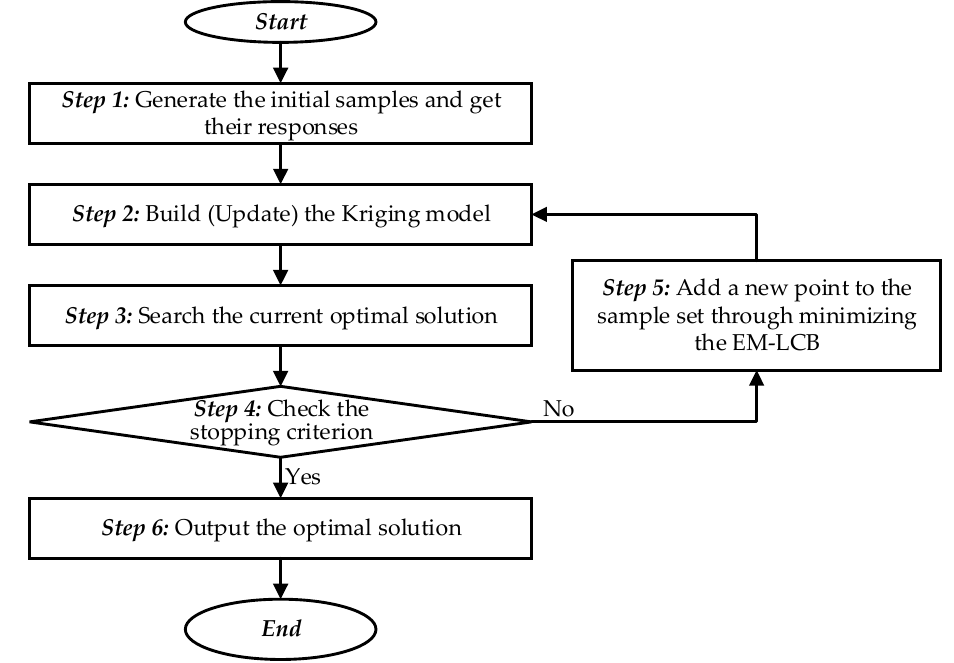
Figure 1. The framework of the proposed entropy weight algorithm (EW-LCB).